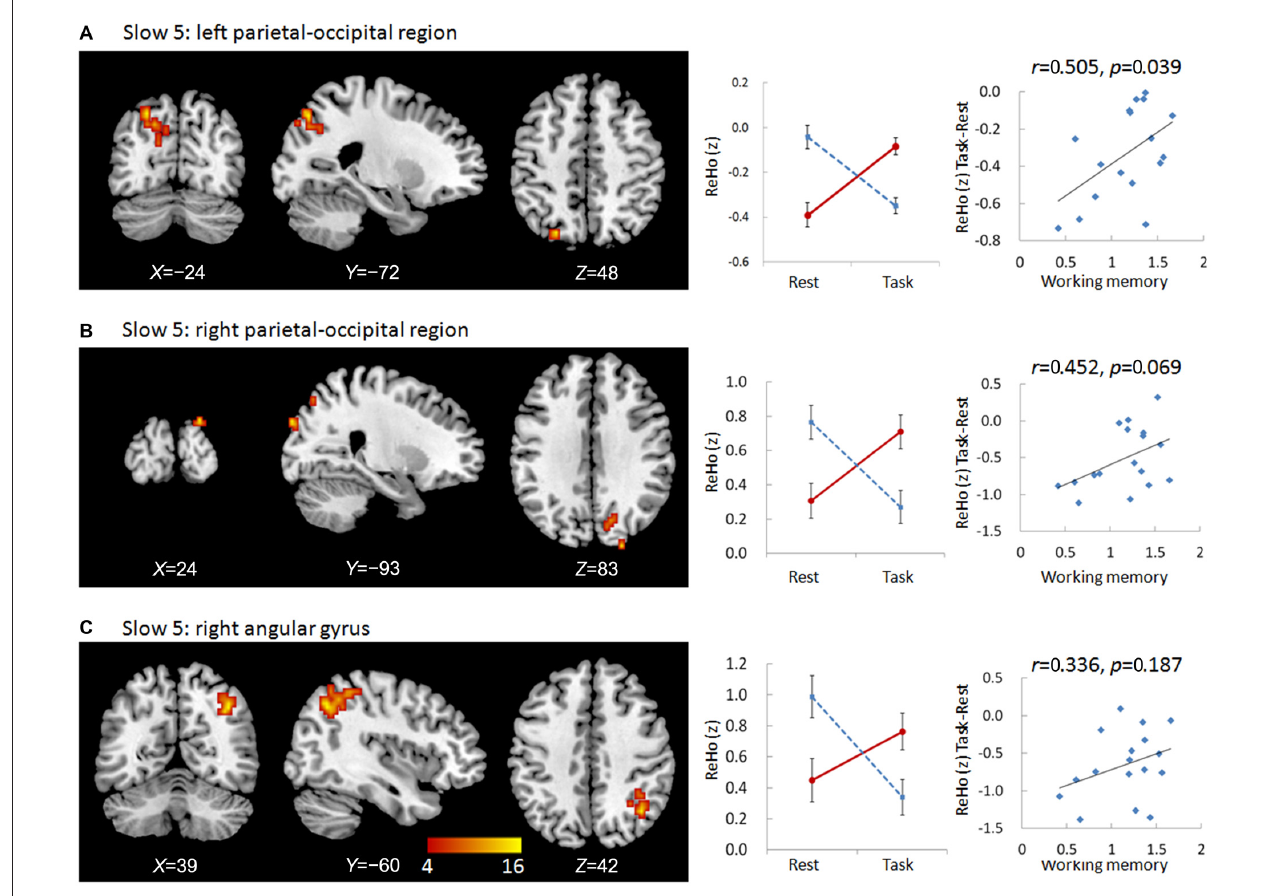
FIGURE 2 | Regions showing group × state interactions for ReHo in slow-5 including the left parietal-occipital region (A), the right parietal-occipital region (B), and the right angular gyrus (C). The color bar demonstrates F values. The corresponding graphs show the interaction patterns (middle panels) and correlation (right panels) between state-related change (task minus resting) of ReHo and working memory performance in MCI patients.